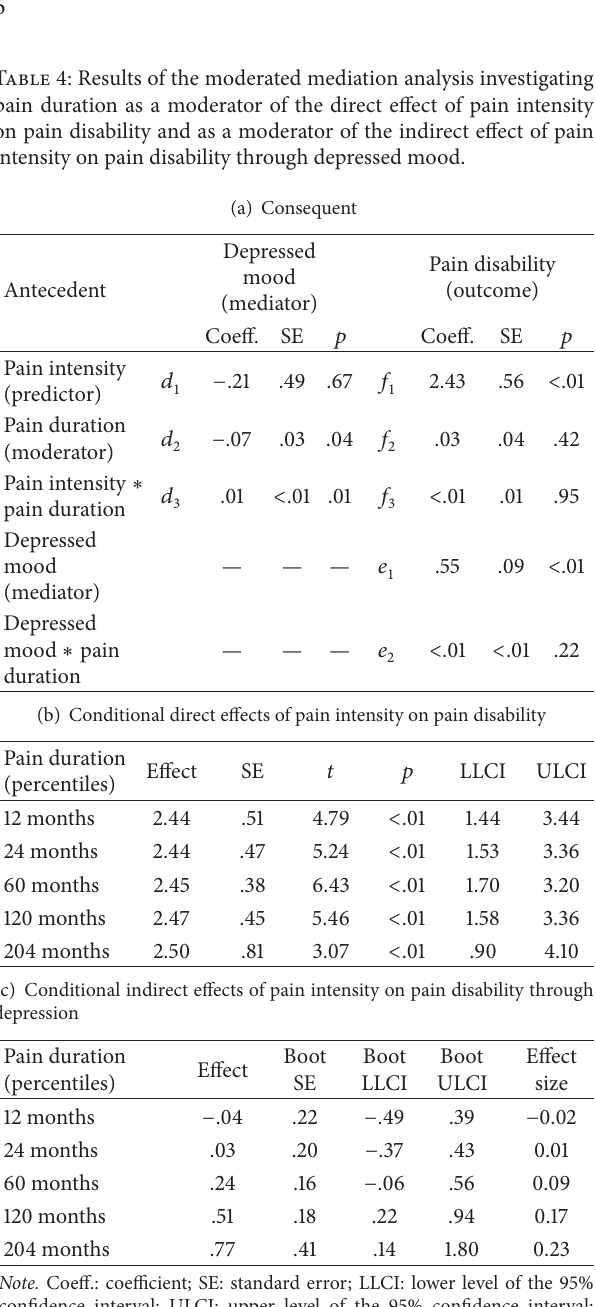
Table 4: Results of the moderated mediation analysis investigating pain duration as a moderator of the direct effect of pain intensity on pain disability and as a moderator of the indirect effect of pain intensity on pain disability through depressed mood.